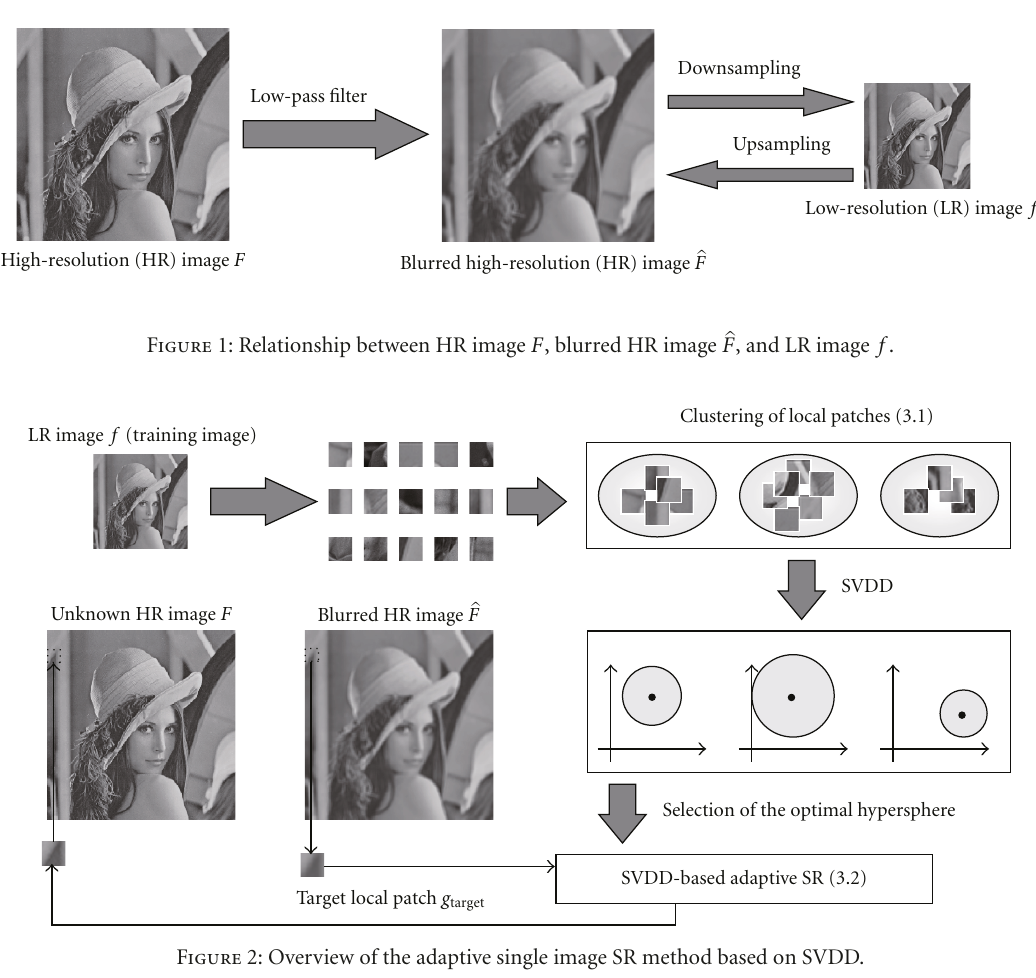
Figure 2: Overview of the adaptive single image SR method based on